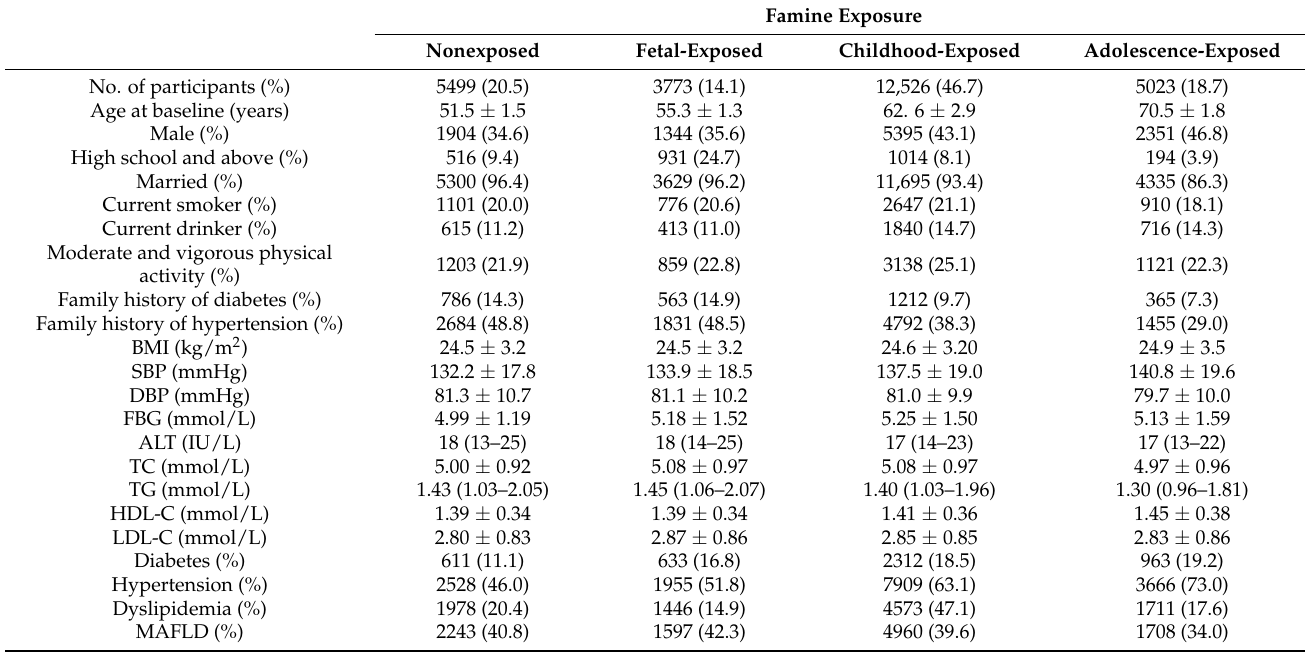
Table 1. Characteristics of 26,821 participants according to famine exposure in early life.